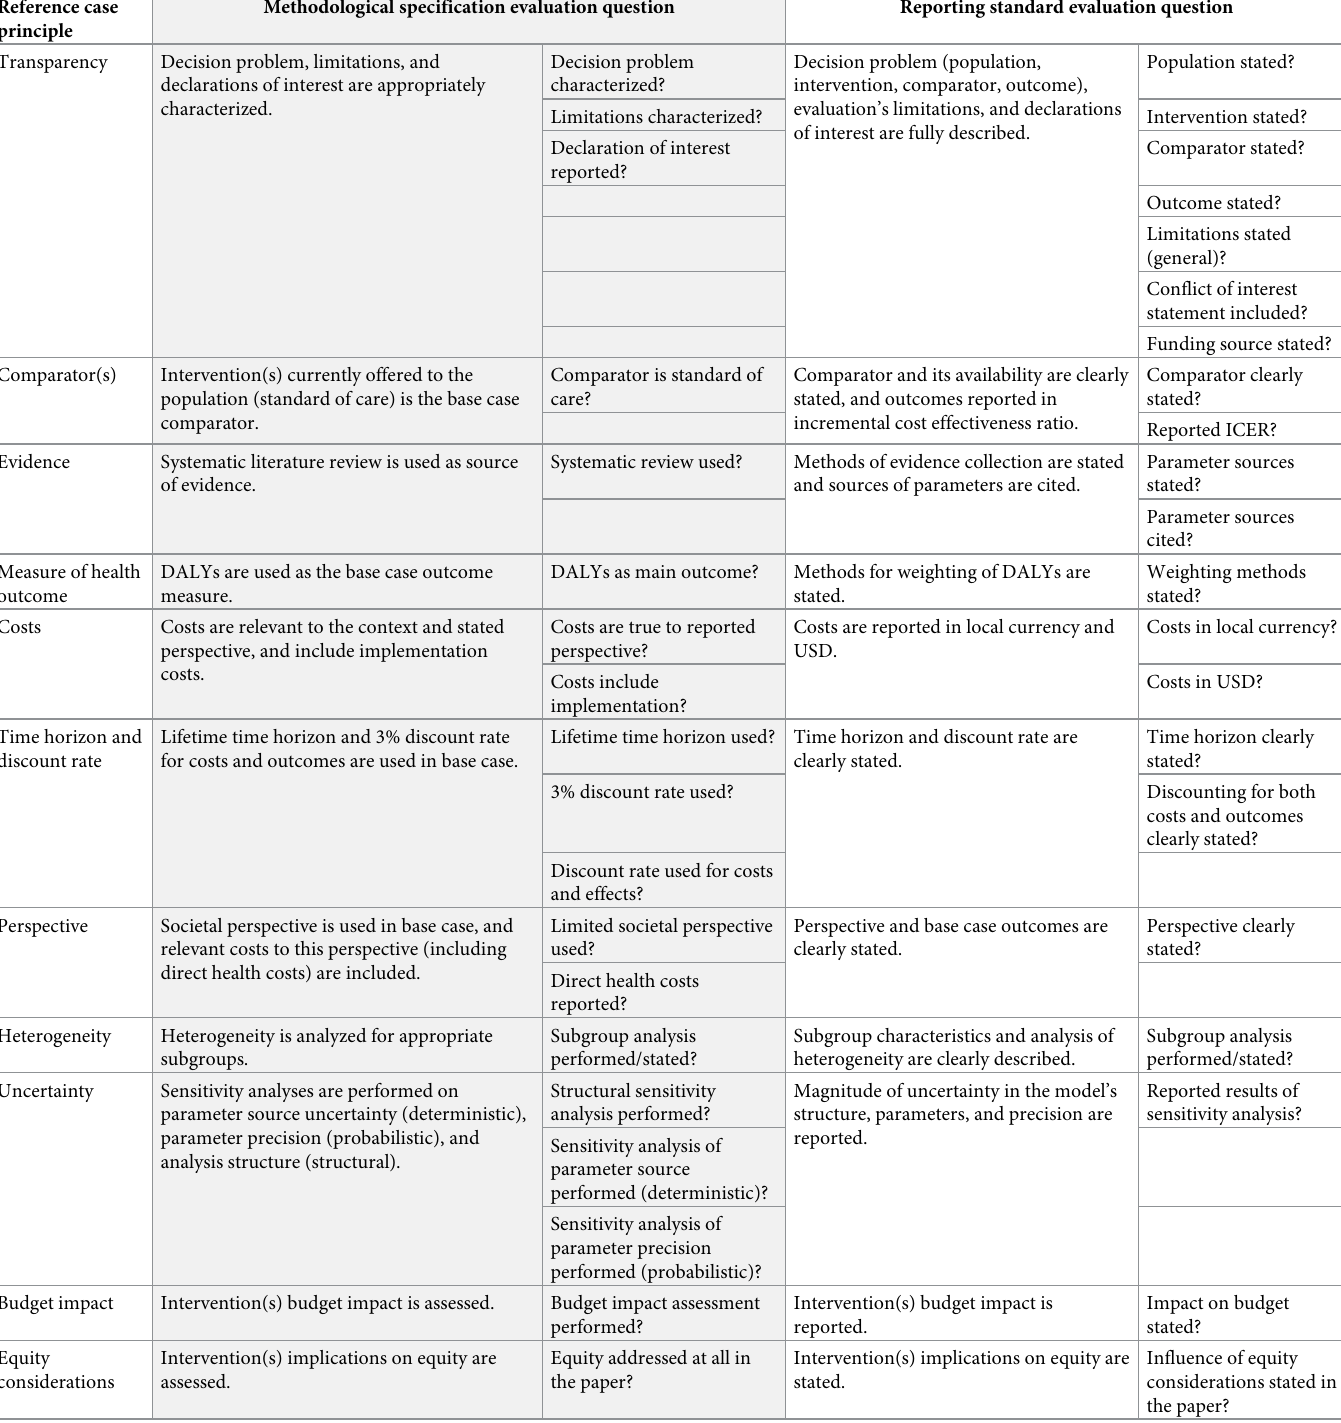
Table 1. Evaluation criteria for adherence to the iDSI reference